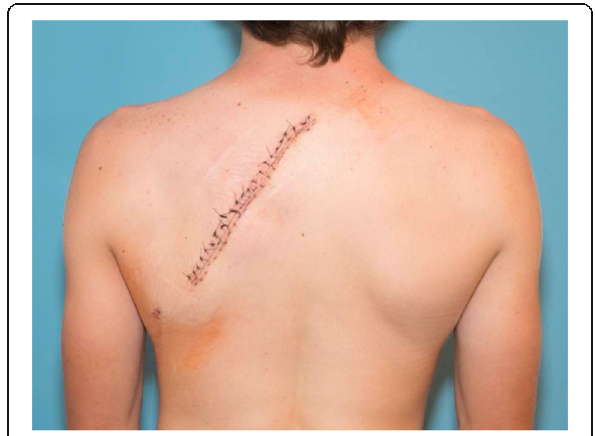
Fig. 4 Postoperative presentation of the patient demonstrating a healed scar without